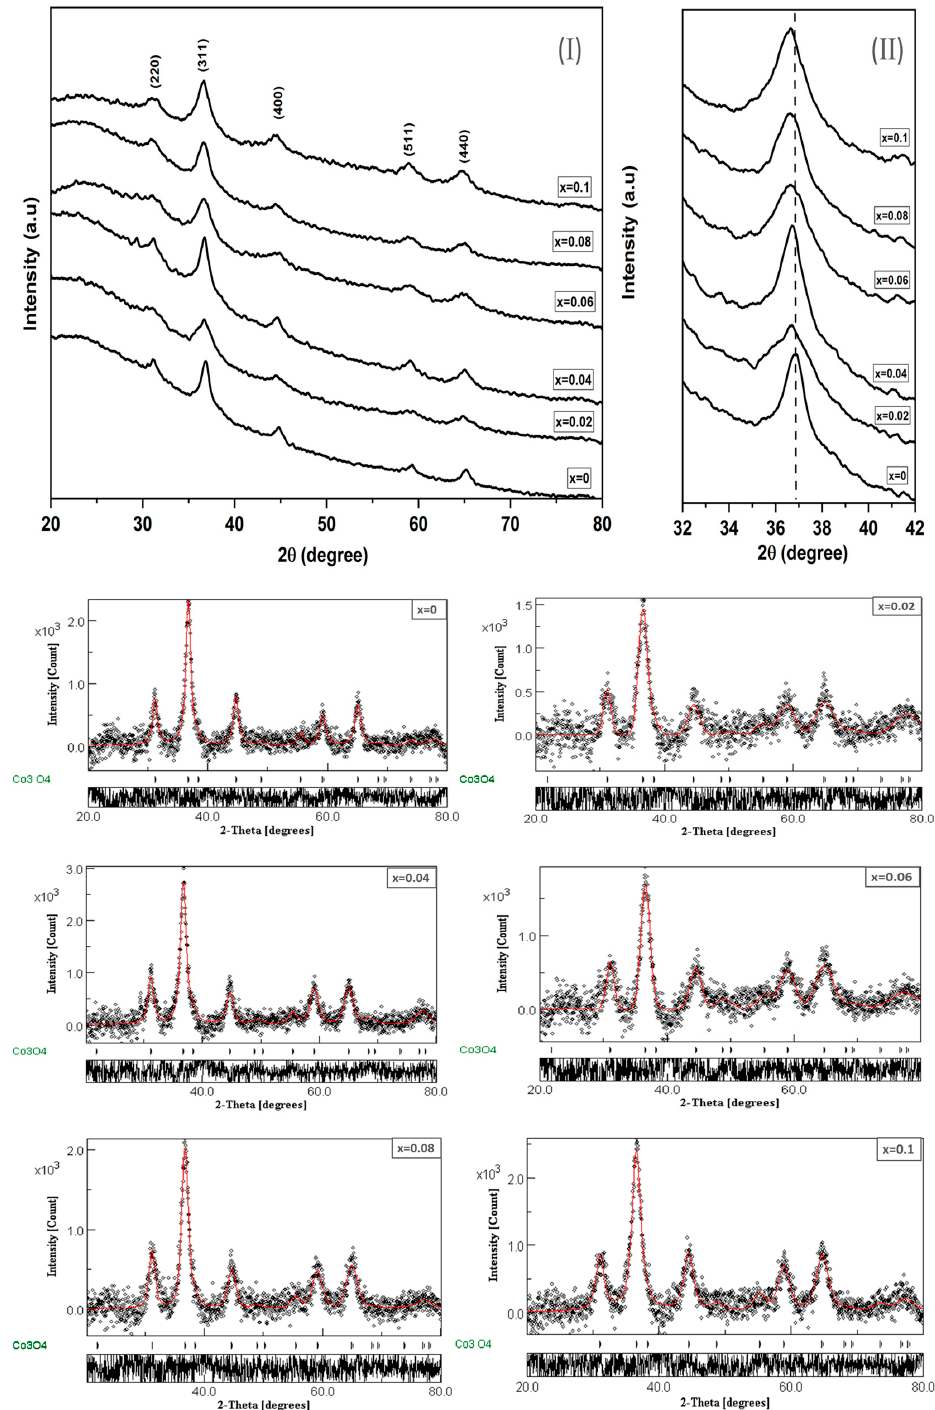
Figure 1. ( I ) XRD patterns of Cr doped Co 3 O 4 ( II ) the shifting of (311) peaks positions to lower 2 θ values and Rietveld refinement profile for Cr x Co 3 − x O 4 thin films using MAUD program.